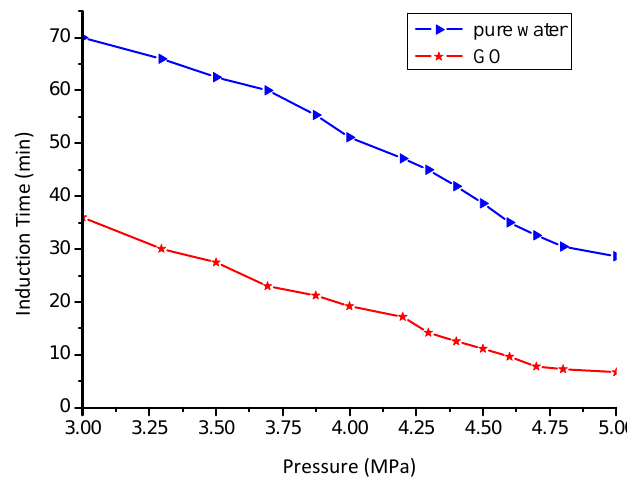
Figure 5. Induction time in different initial pressures with GO or pure water at 279 K.